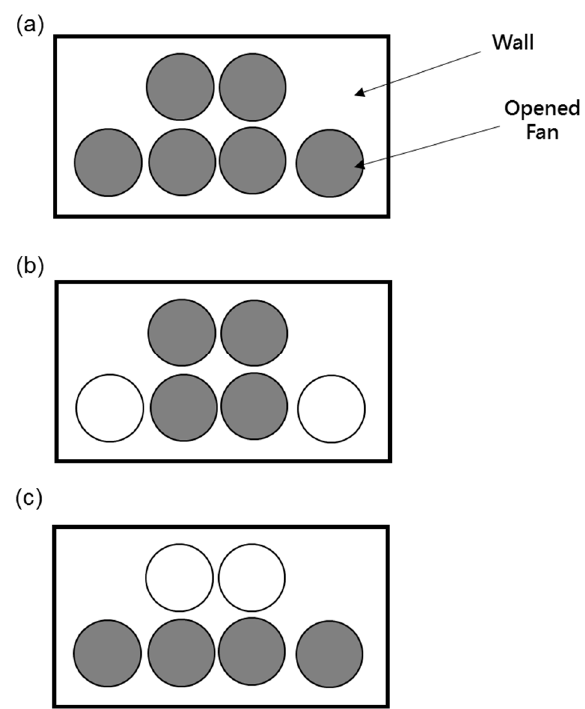
Figure 6. Three fan modes. ( a ) All fans were active; ( b ) four central fans were active; ( c ) four fans below were active.